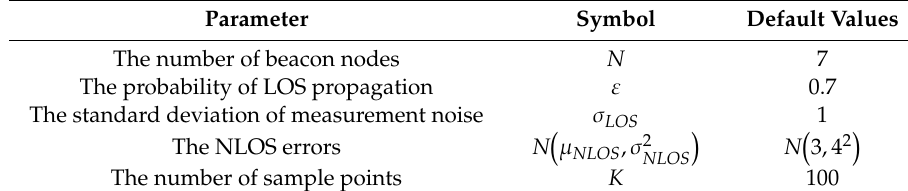
Table 1. The default parameters of a Gaussian distribution.